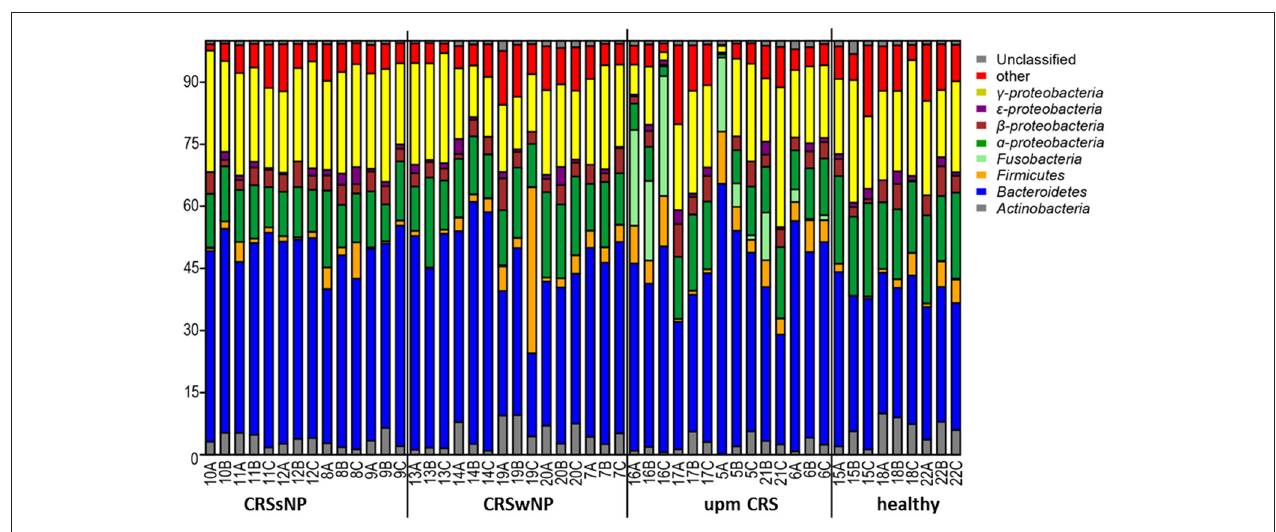
FIGURE 2 | Bacterial community composition is shown on phylum/class level for unilateral purulent maxillary CRS (upm CRS), CRS with nasal polyps (CRSwNP), and CRS without nasal polyps (CRSsNP). The samples were ordered based on the different CRS types. For detailed information of each sample refer to Table 3 .